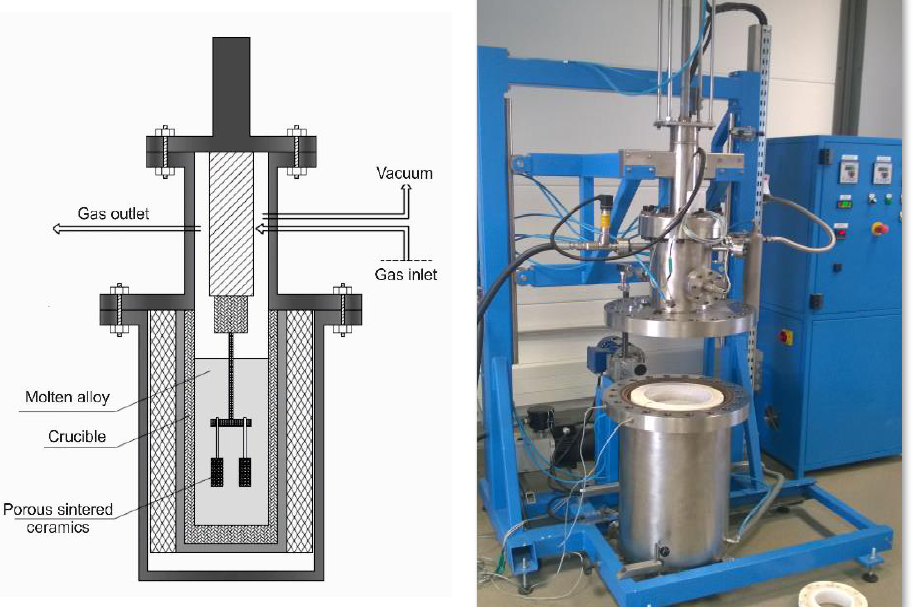
Figure 1. Diagram and view of a device designed for the gas-pressure infiltration of a porous ceramic.